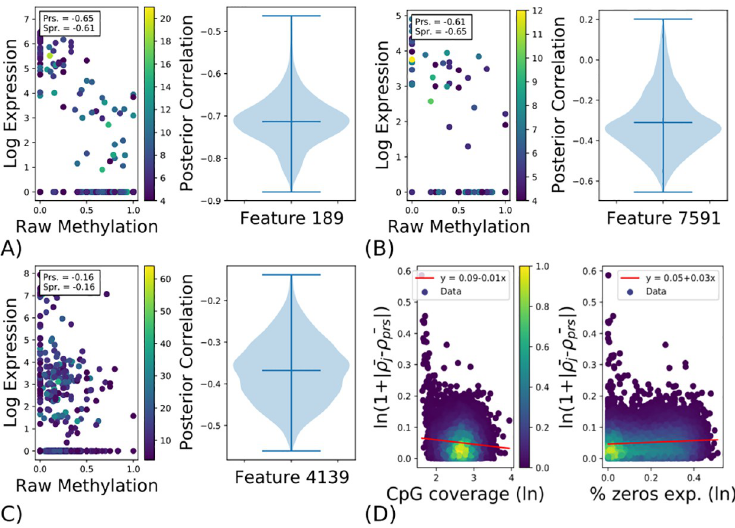
Fig 4. SCRaPL’s behavior compared to Pearson/Spearman correlation in micro and macro scale. In all figures apart from 4D the scatter plot depicts raw data for chosen features color-coded by CpG coverage, and normalized expression plotted in the log (1 + x ) scale. The violin plots depict the posterior correlation densities estimated by SCRaPL for the raw data in their left hand side. (4A) Example where both SCRaPL and Pearson/Spearman identify the feature’s association as significant. (4B) Example were only Pearson/Spearman identifies the feature’s association significant. (4C) Example were only SCRaPL identifies the feature’s association significant. (4D) Scatter plots to demonstrate the negative/positive relationship between alternative correlation estimates and CpG coverage/% zeros in expression respectively. ( � r and ρ prs in Fig 4D are posterior mean and Pearson correlation for feature j j